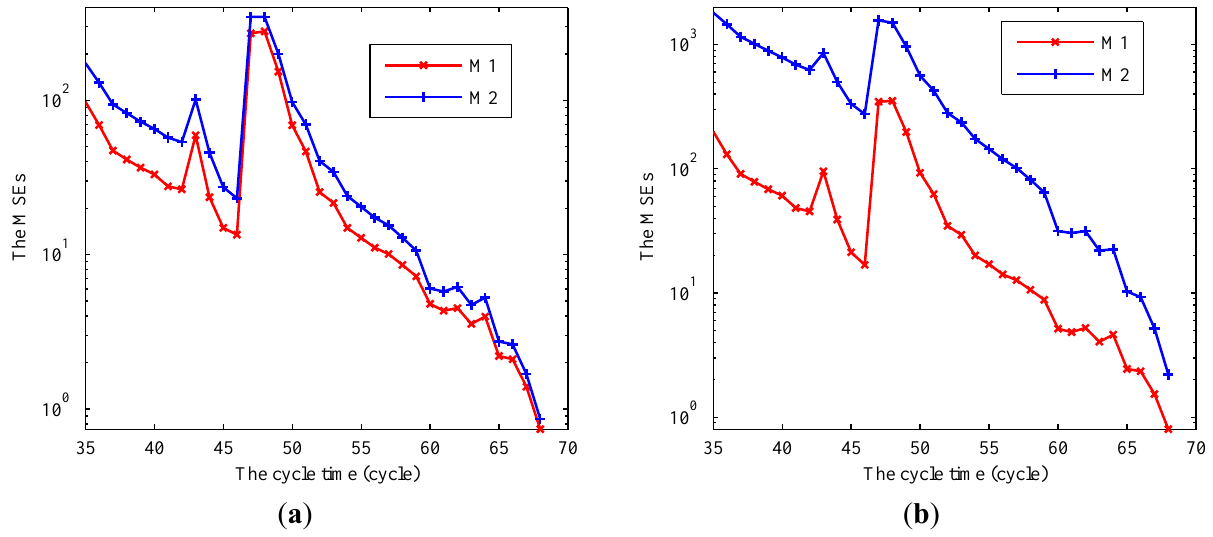
Figure 8. The mean square errors (MSEs) at some condition monitoring (CM) points: ( a ) right prior information; and ( b ) inappropriate prior information.